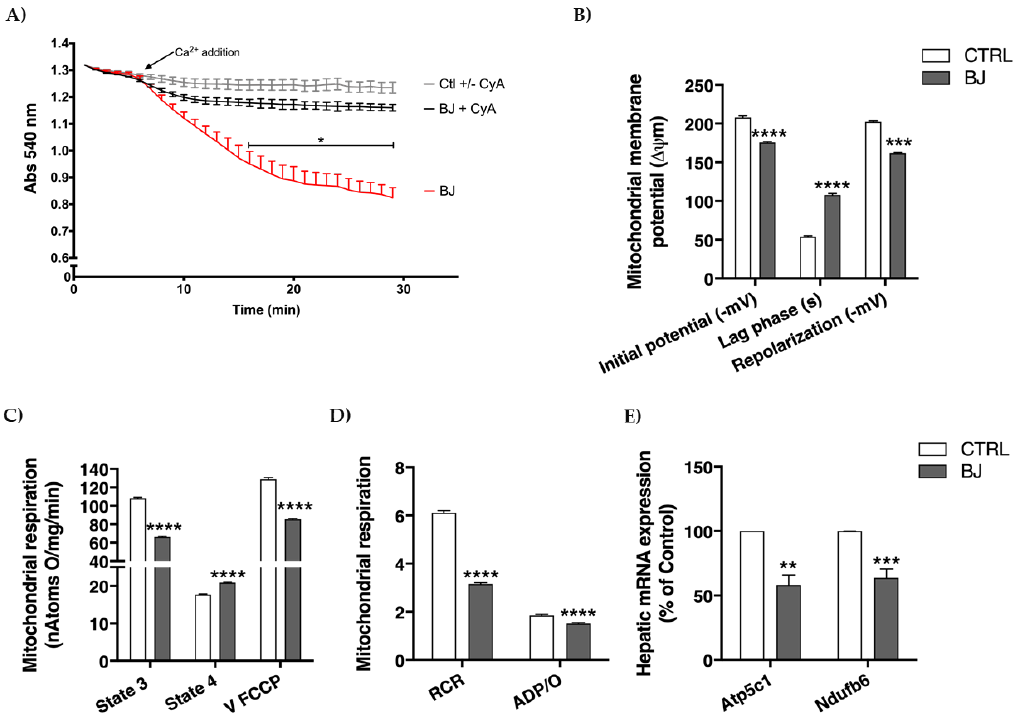
Figure 4. Hepatic mitochondrial function assessment: susceptibility to the induction of mitochondrial permeability transition (MPT) ( A ); mitochondrial membrane potentials and lag phase ( B ); parameters of mitochondrial respiration ( C , D ); hepatic mRNA expression of genes involved in mitochondrial respiratory chain ( E ). Data are presented as mean ± SEM ( n = 6–8 / group); * p < 0.05, ** p < 0.01, *** p < 0.001, **** p < 0.0001 vs. CTRL group.